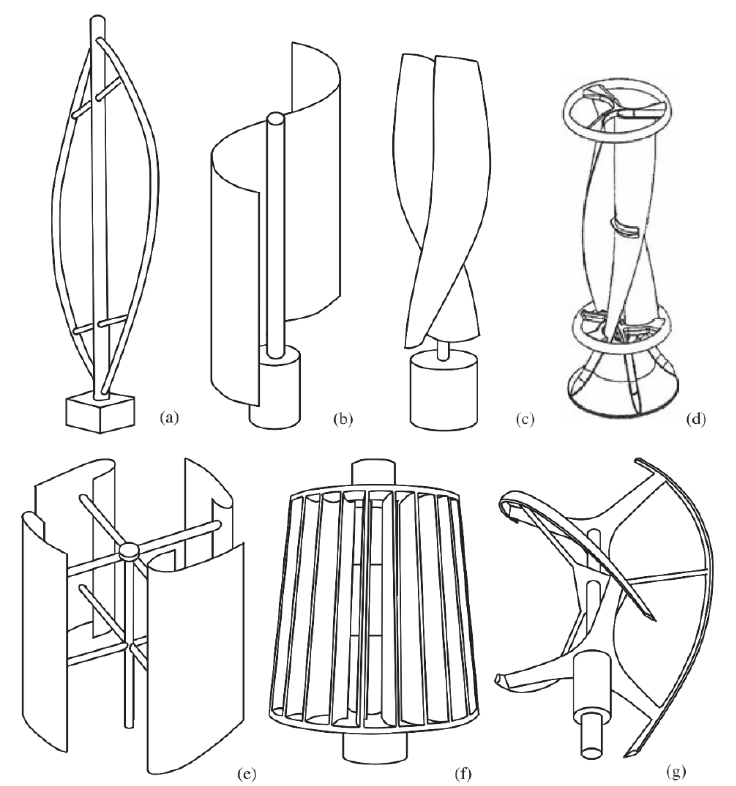
Figure 1. Several typical types of vertical-axis wind turbines: ( a ) Darrius; ( b ) Savonius; ( c ) Solarwind; ( d ) Helical; ( e ) Noguchi; ( f ) Maglev; ( g ) Cochrane [17].